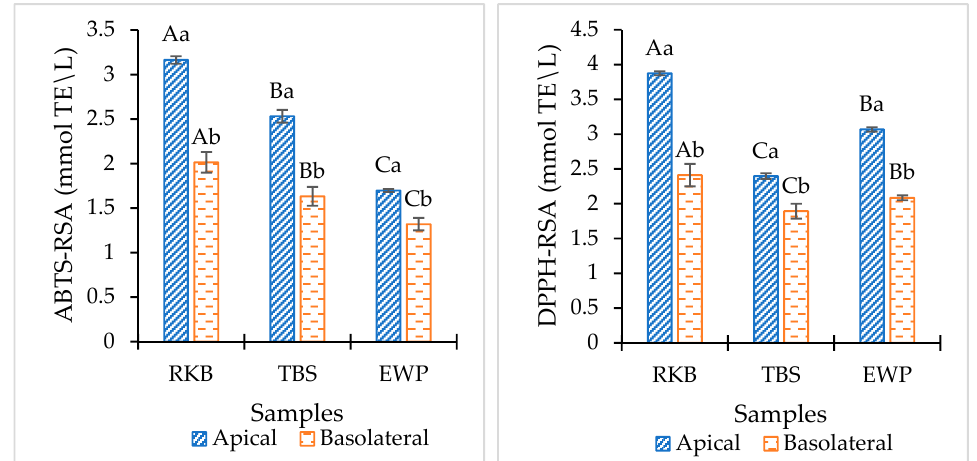
Figure 8. Antioxidant activity of red kidney bean isolate (RKB), threadfin bream surimi (TBS) and egg white powder (EWP) hydrolysate before transport (Apical) and after 4-h transport appeared in basolateral-side permeates (Basolateral). Different uppercase letters on the bars within the same side of Caco-2 cell monolayer denote significant differences between the samples ( p < 0.05). Different lowercase letters on the bars within the same protein used denote significant differences between apical and basolateral side ( p < 0.05). Error bars represent standard deviation ( n =